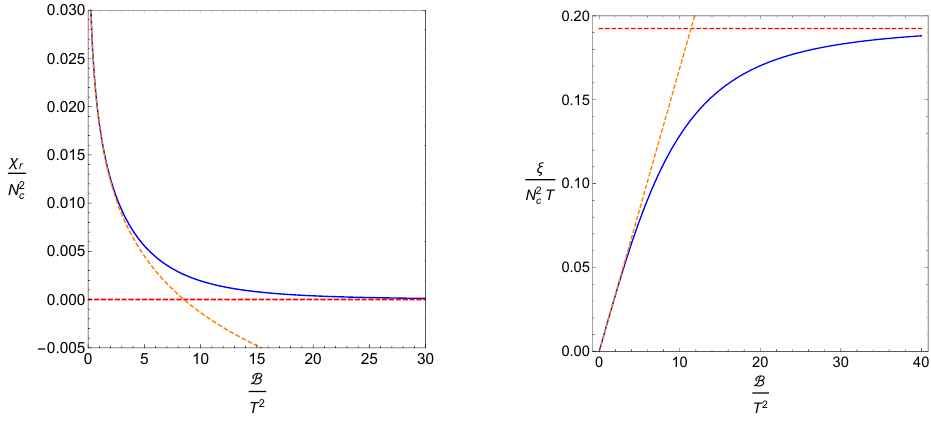
Figure 5 . Left panel: magnetic susceptibility χ r , divided by N 2 panel: dimensionless pyro-magnetic coefficient ξ/T , divided by N 2 both panels the blue lines represent our numerical results whilst the orange and red dashed lines represent the analytical solutions at small and large b respectively, obtained in appendices A and